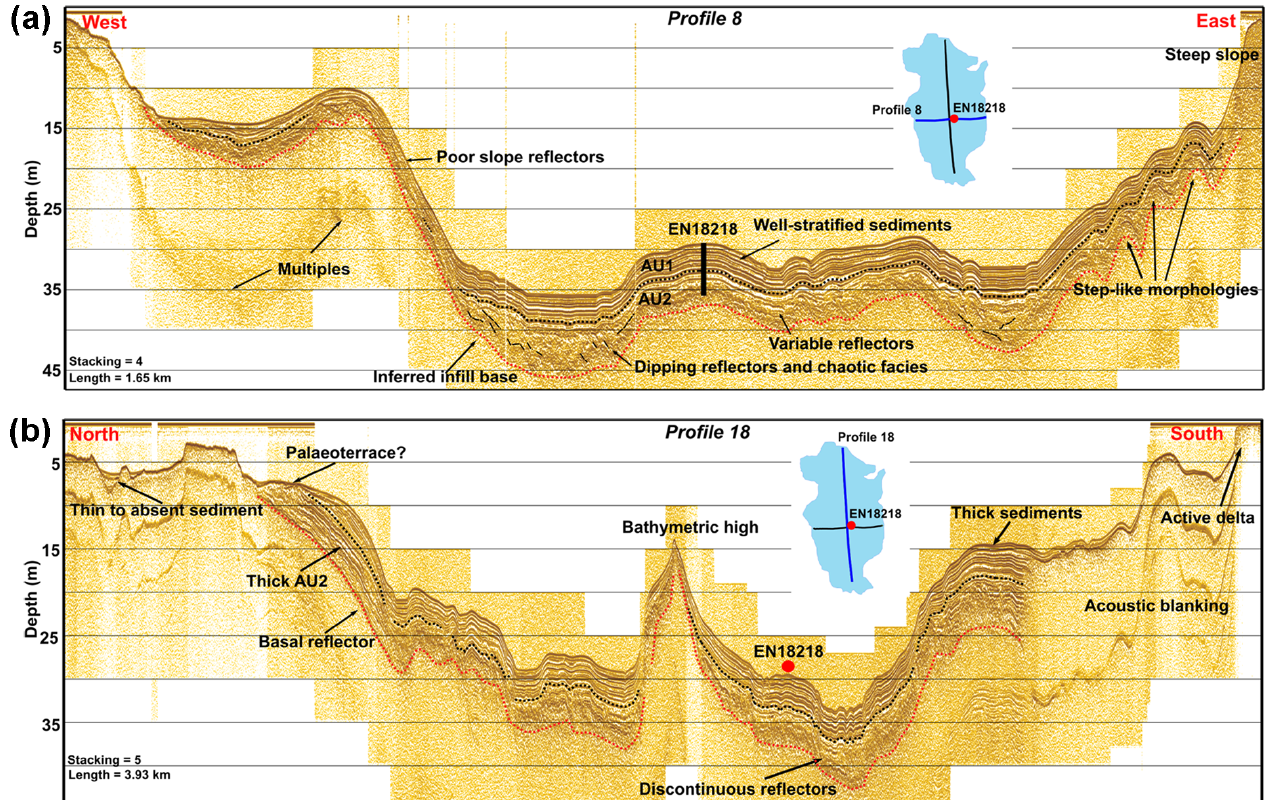
Figure 2. Interpreted hydroacoustic profiles from Lake Rauchuagytgyn (profile 8 and profile 18). Both profiles pass close to the drilling location of EN18218. Shown are inferred major hydroacoustic boundaries defined that are connected with major lithological changes recorded by EN18218 and interpreted across the